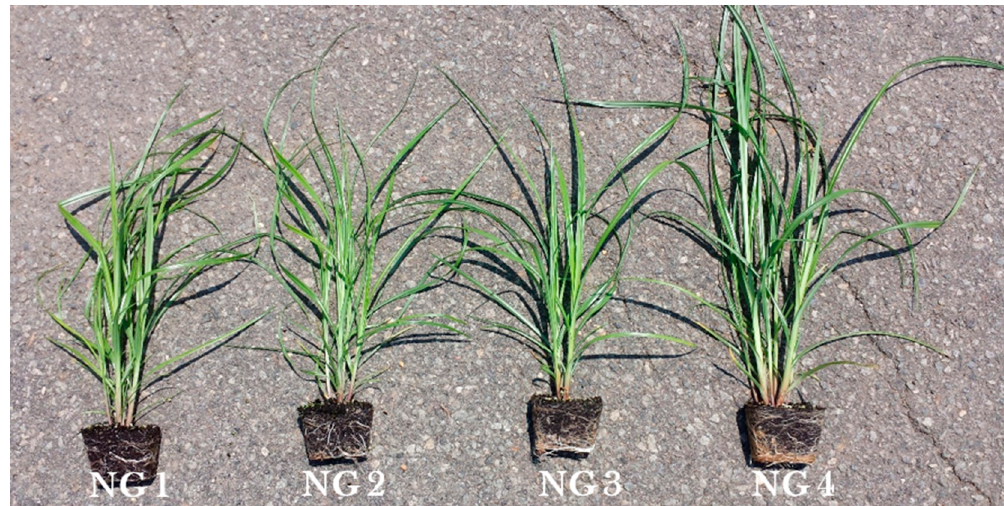
Figure 1. Tigernut plantlets at four weeks (30 days) after planting the tuber in Pro-Mix BX brand media in 48-hole flats under hoop house conditions and fertilized with NPK 20-20-20 solution (30 g/gallon or 3.75 L of water) at 15 days after planting. The NG selections originated from Nigeria and varied in size from small (NG1) to large (NG4). (Photo: Albert Ayeni).